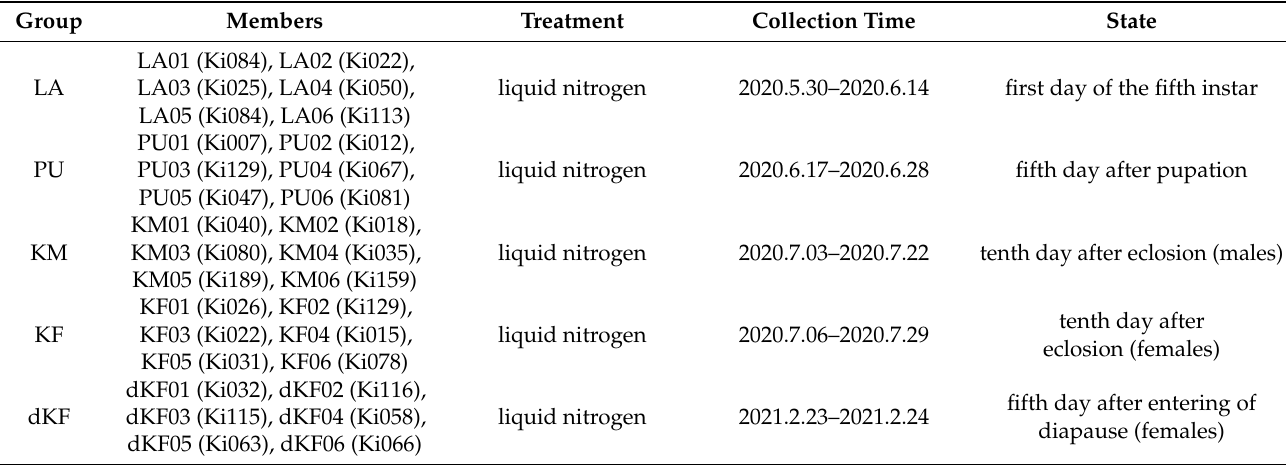
Table 1. Information of samples used for untargeted metabolomic